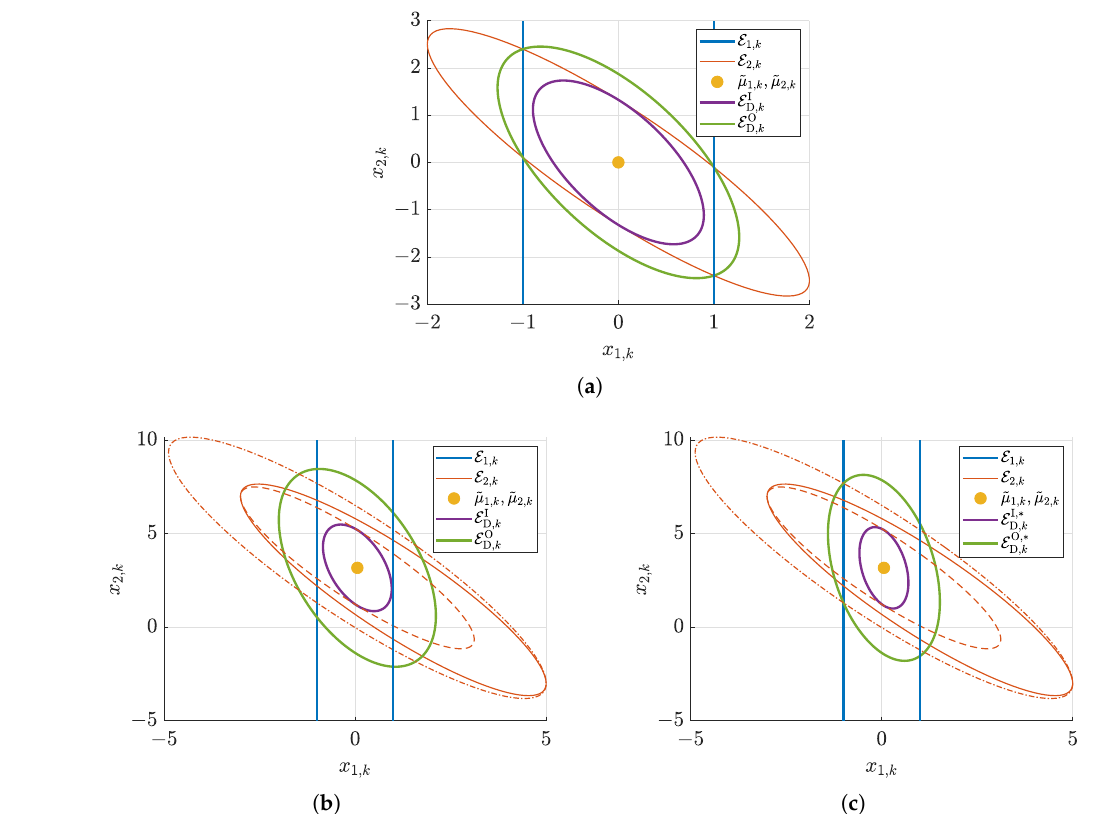
; outer bound: D, k